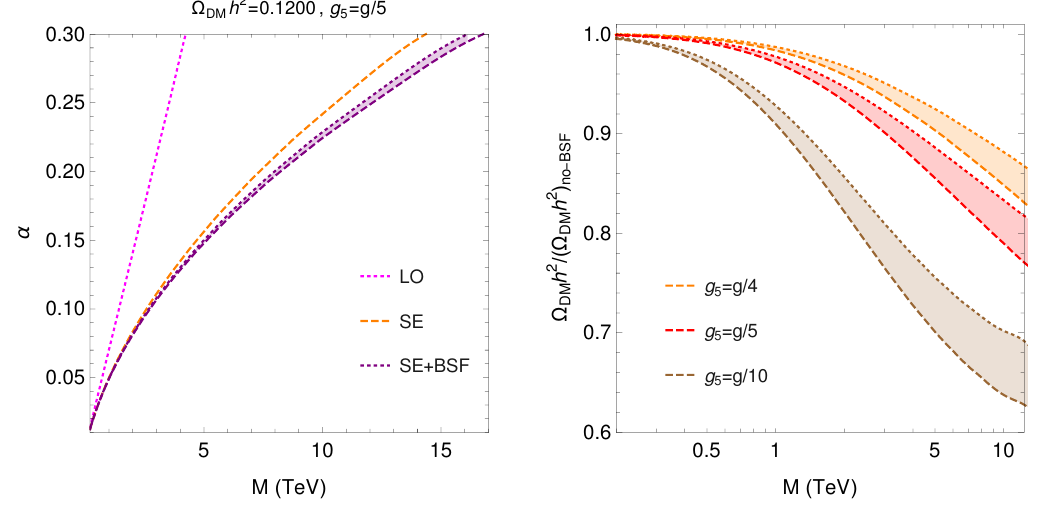
Figure 11 . Left: parameter space in the ( M, α ) -plane that reproduces the observed DM energy density for g 5 = g/ 5 . The purple dotted curve accounts for the ground state only, whereas the purple-dashed curve corresponds to the inclusion of excited states. Right: ratio between the DM energy density as obtained with and without bound-state effects. The parameter α is fixed as a function of the mass M to account for the observed DM energy density when bound-state effects are considered. Dashed (dotted) lines do (not) include excited